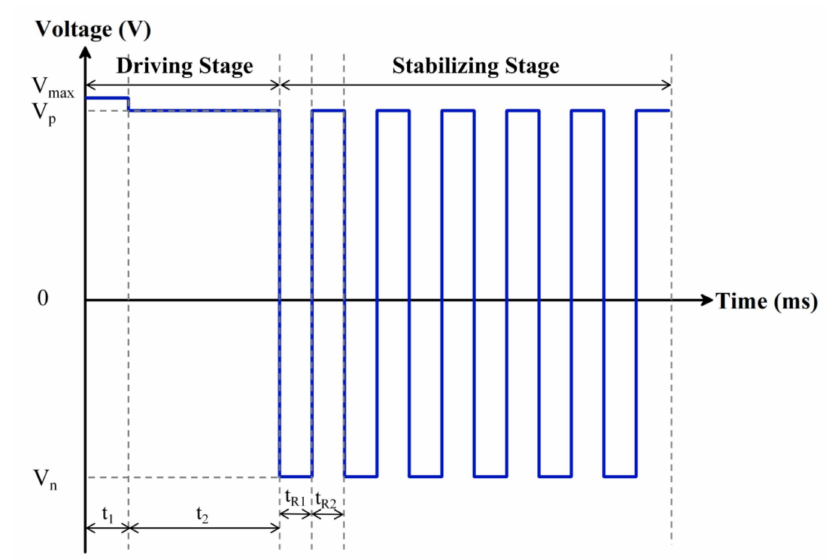
Figure 5. The proposed driving waveform for suppressing the charge trapping effect. It was combined with a driving stage and a stabilizing stage. The driving stage was an overdriving voltage and a DC voltage; the stabilizing stage was an AC pulse signal. Here, V max is the overdriving voltage of the driving stage, V p is the DC voltage of the driving stage, V n is the negative voltage of the stabilizing stage, t 1 and t 2 are the duration of the overdriving voltage and DC voltage, respectively, t R 1 is the driving time of the positive voltage in the stabilizing stage and t R 2 is the release time of the negative voltage in the stabilizing